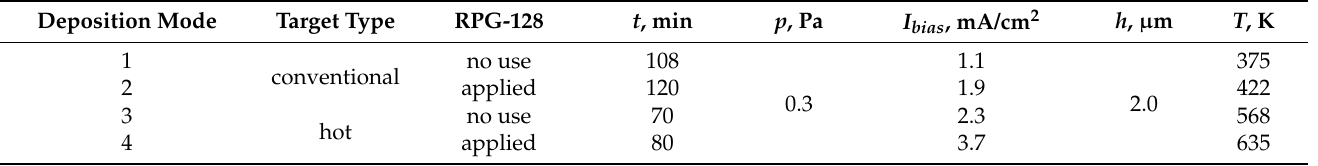
Table 1. Deposition parameters of Cr